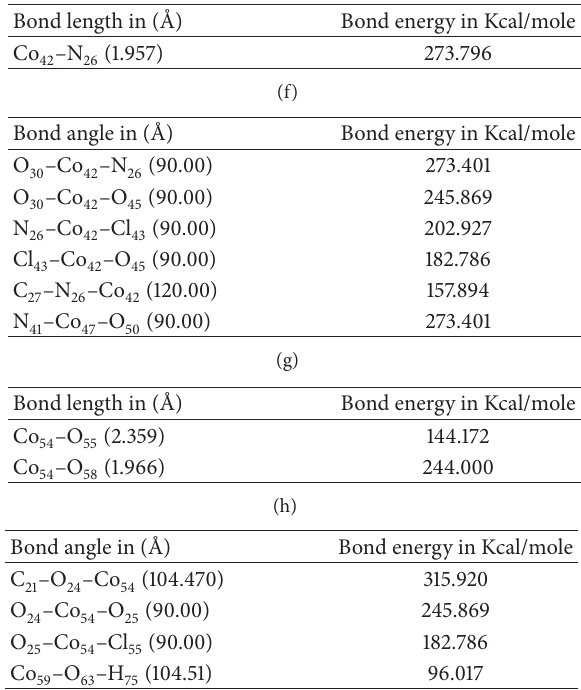
Table4:(a)X-raydiffractiondataofthecomplex[Co (b) X-ray diffraction data of the complex [Co